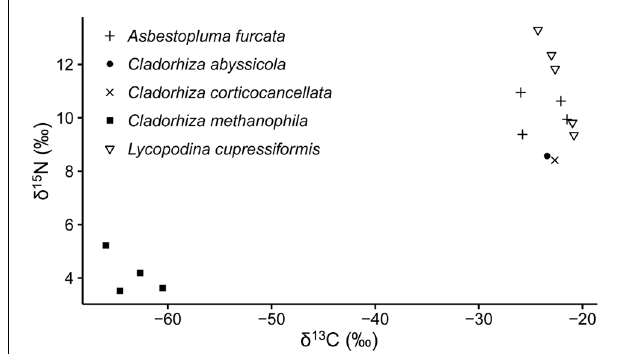
FIGURE 3 | Stable isotope values of carbon ( δ 13 C) and nitrogen ( δ 15 N) of a selection of cladorhizids collected at the Troll Wall vent field, and the BAP diapiric field.